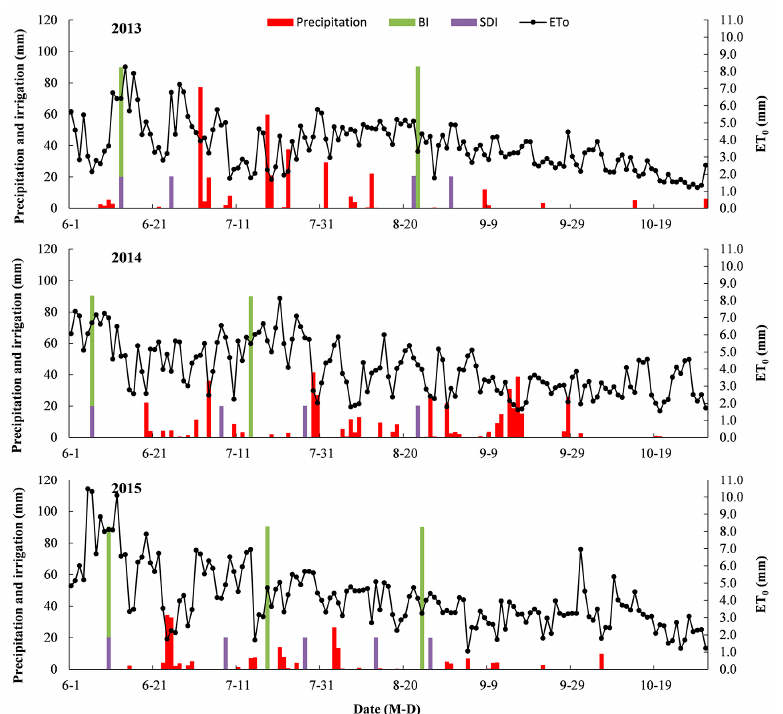
Figure 2. Irrigation, precipitation and ET 0 during the experimental seasons from 2013 to 2015. Abbreviations: BI, border irrigation; and SDI, surface drip irrigation.